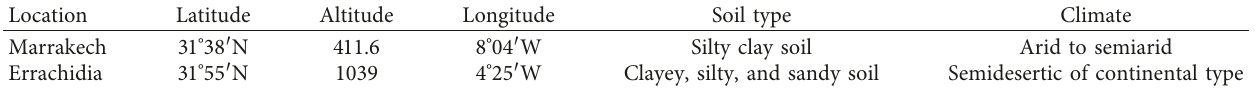
Table 1: Characteristics of the two growing sites (Marrakech and Errachidia).